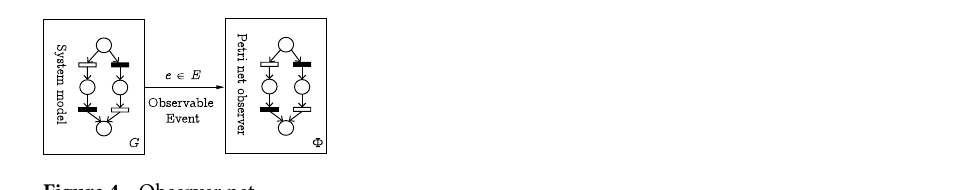
Figure 4. Observer